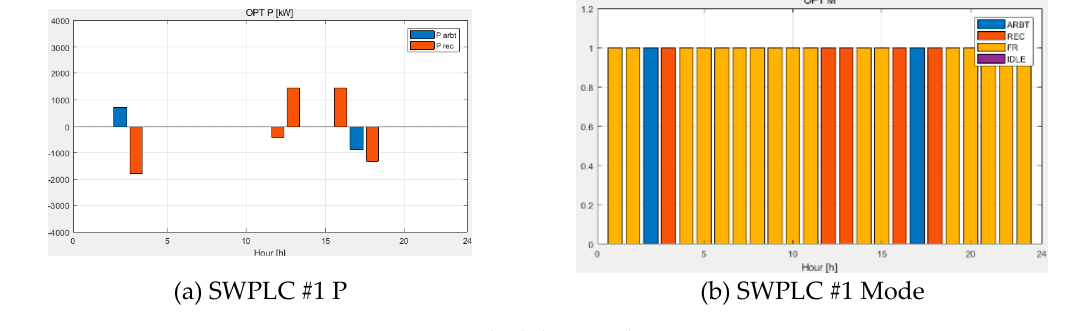
Figure 13. Scheduling results in TEMS. Energies 2019 , 12 , x FOR PEER REVIEW